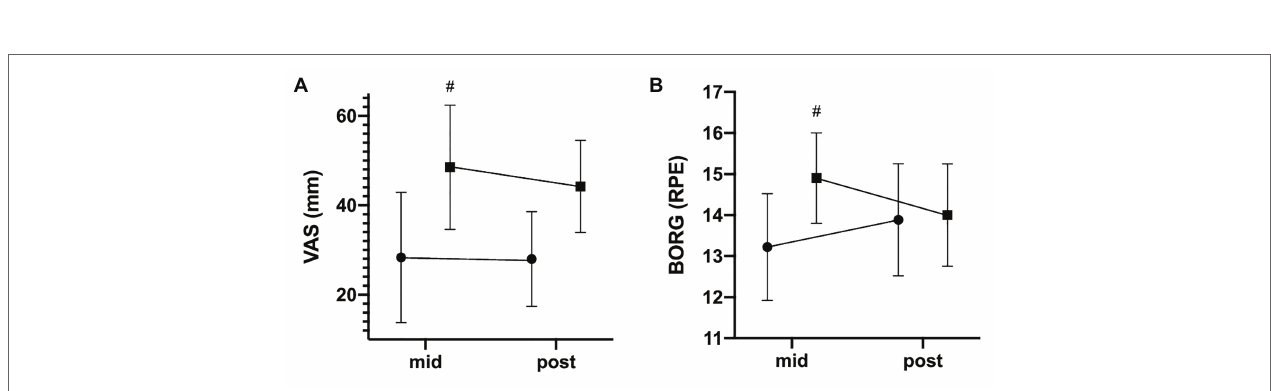
FIGURE 4 | Development of perceived exertion and pain sensation. The data are presented as mean values ± SD. The graphs show the participants’ (A) pain sensation (VAS) and (B) perceived exertion on the Borg scale after 3 and 6 weeks. # statistically significant difference between groups. • = rBFR, ■ =